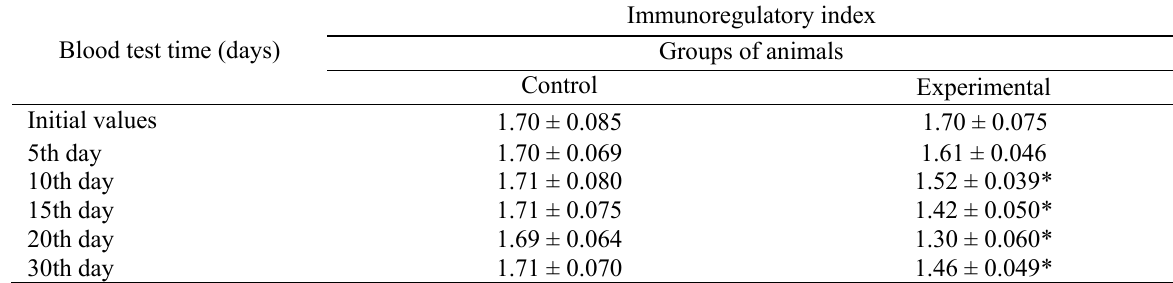
The concentration of immunoglobulins in the blood of bulls under the influence of chronic cadmium toxicosis (М ± m, n = 5)